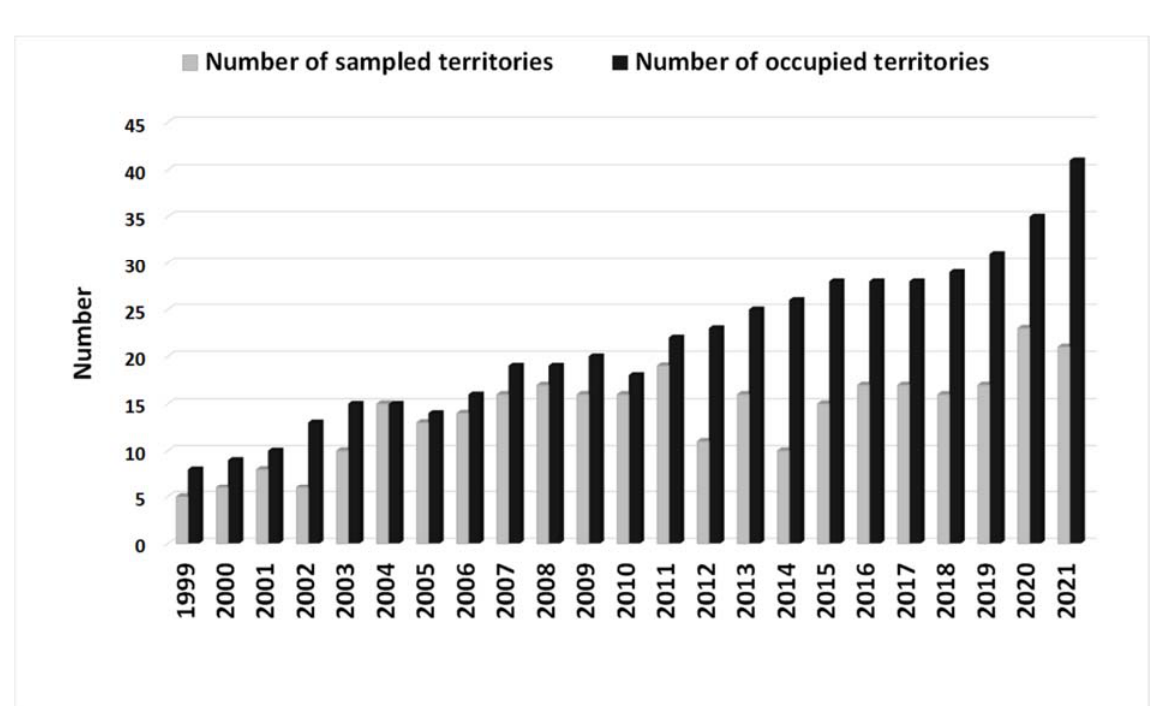
Figure 2. Number of sampled eastern imperial eagle territories and number of occupied territories in different